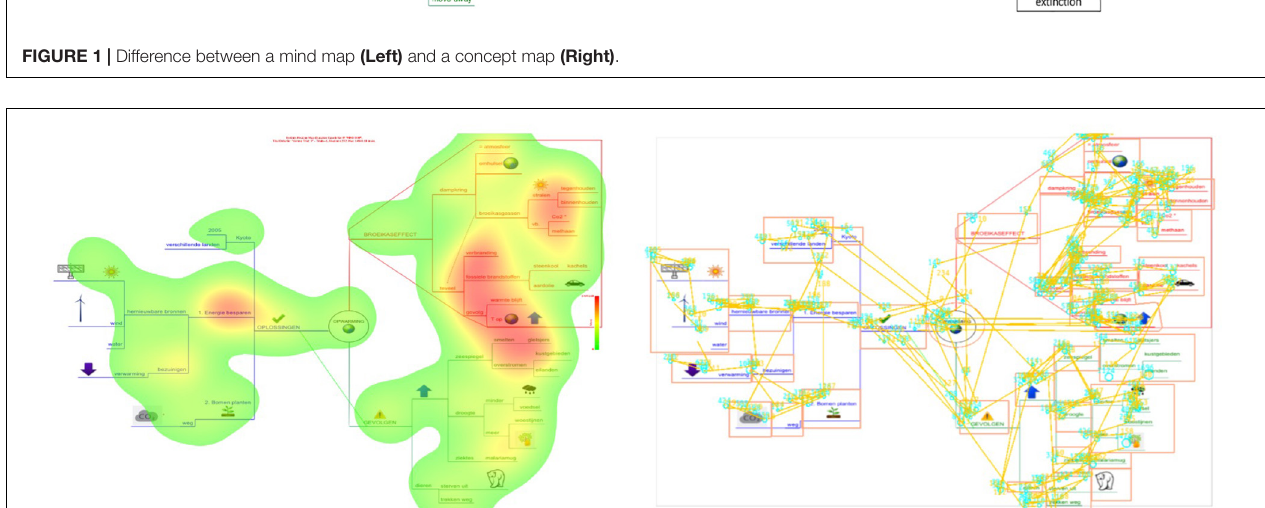
FIGURE 2 | Example of a heat map (Left) and fixation and saccade map (Right) . The darker the area in the heat map (Left) , the more intensively students looked at that particular region in the mind map. Fixations in the saccade map (Right) are represented by circles, saccades by lines. Interest areas (IA) are represented by